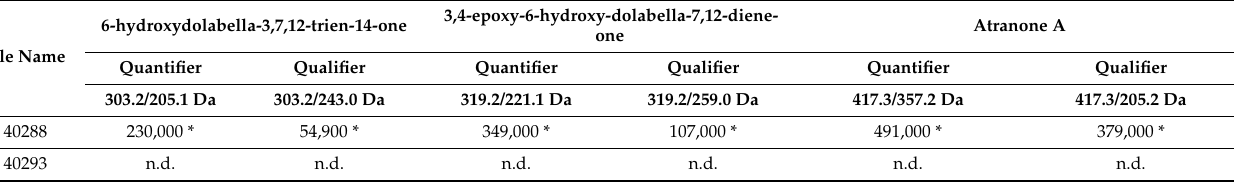
Table 2. Detected atranone precursors and atranone A by LC-MS/MS measurement.